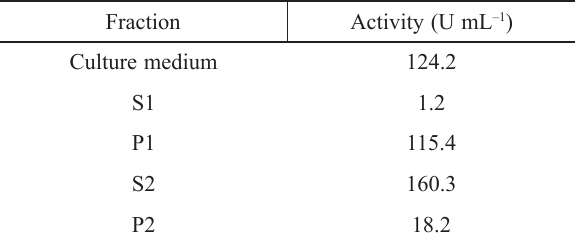
Table 1 – Cellular localization of lipase from Anoxybacillus sp.